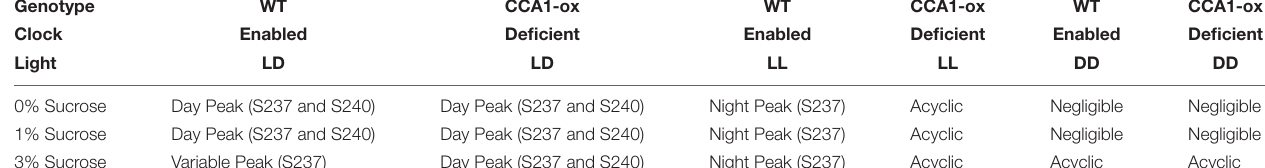
TABLE 1 | Summary of RPS6-P patterns in WT (clock-enabled) and CCA1-ox (clock-deficient) strains under LD, LL, and DD conditions. Genotype